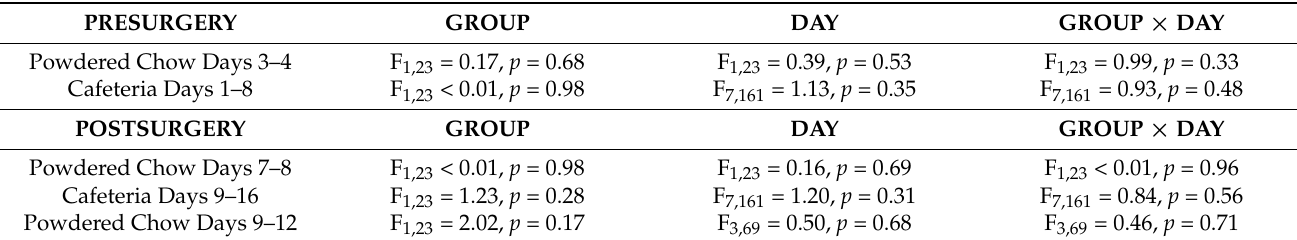
Bolded values indicate statistical significance ( p ≤ Table 9. Paired t -tests Comparing 22-H Meal Duration within Groups across Diets.